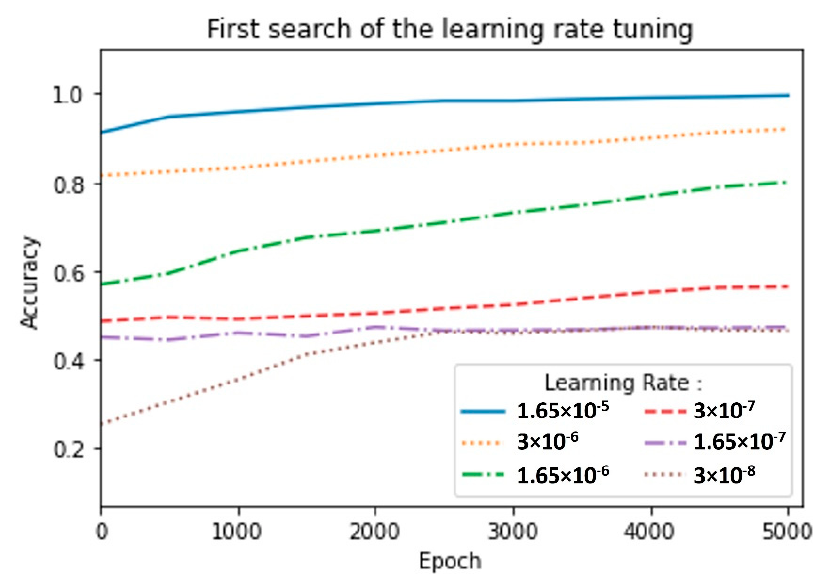
Figure 8. Confusion matrix for first search learning rate tuning.